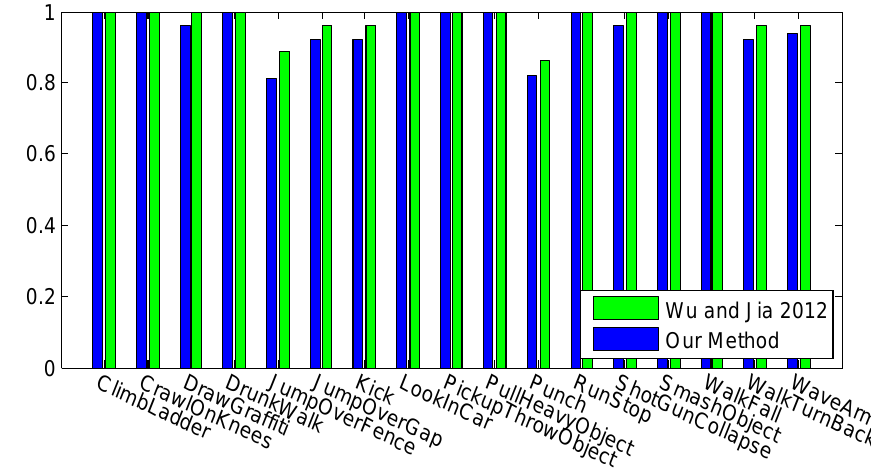
Figure 12. Class-level recognition results of the MuHAVi dataset, in comparison with Wu and Jia